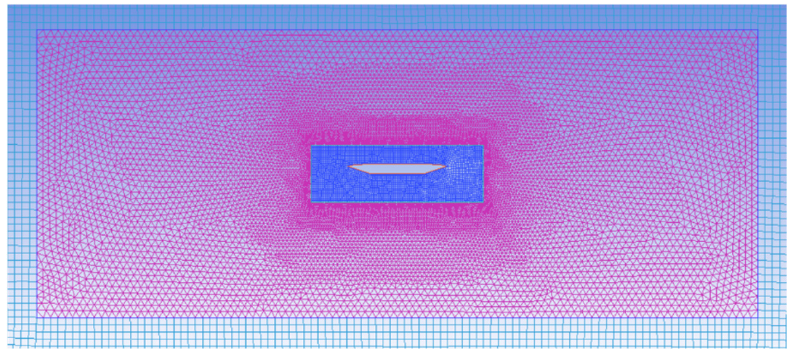
Figure 9. Moving grid region.